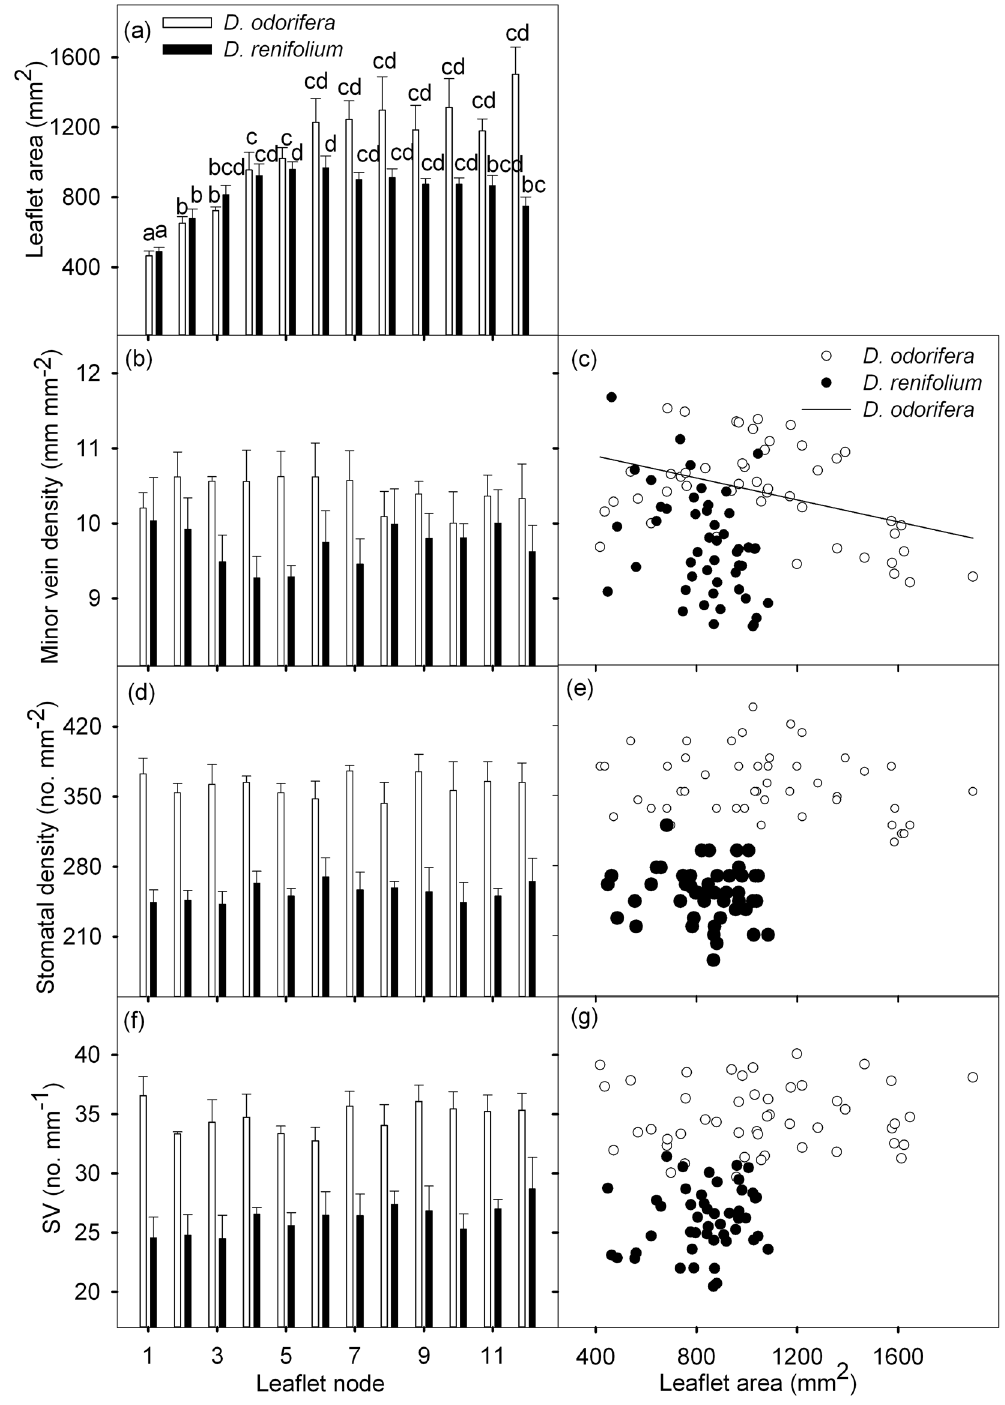
Figure 5. Relationships between traits in sun leaves within D . odorifera and D . renifolium . ( a ), ( b ), ( d ) and ( f ) Relationships between leaflet area, minor vein density (MVD), stomatal density (SD), stomatal number per minor vein length (SV), and leaf node (leaflet node for D . odorifera ). Leaflets were numbered according to their order of production on the rachis or on the shoot. Different lowercase letters in each panel indicate a significant difference in the traits of the same species ( P < 0.05). For D . odorifera and D . renifolium , MVD, SD and SV did not significantly change with the leaflet node. ( c ), ( e ) and ( g ) Relationships between leaflet area (LA), MVD (significant for D . odorifera , MVD = 11.2–0.001 × LA, r 2 = 0.17, P < 0.01), SD, and SV for D . odorifera and D . renifolium . Each symbol represents one